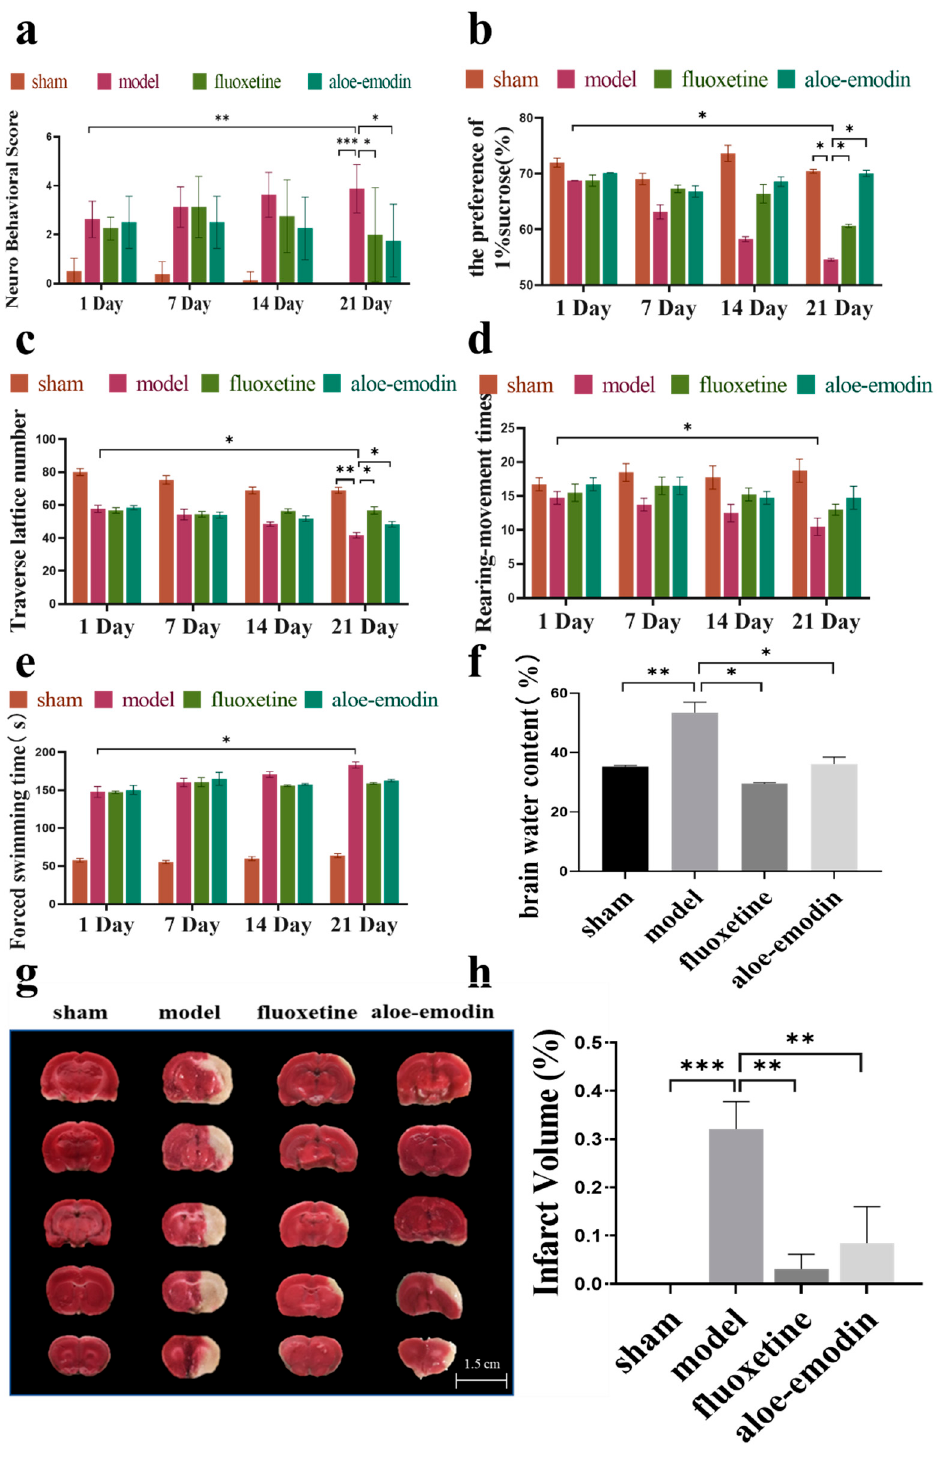
Figure 1. ( a ) Neurofunctional score; ( b ) SPT was used to estimate animal hedonic capacity by measuring sucrose solution intake; ( c ) FST was used to measure animal sensitivity to negative emotions under the threat of drowning; ( d , e ) OFT movement reflects reduced animal activity and curiosity; ( f ) brain water content was used to measure the degree of swelling of brain tissue; and ( g , h ) TTC staining was used for infarct size detection and quantitative analysis. * p < 0.05, ** p < 0.01, *** p < 0.001.